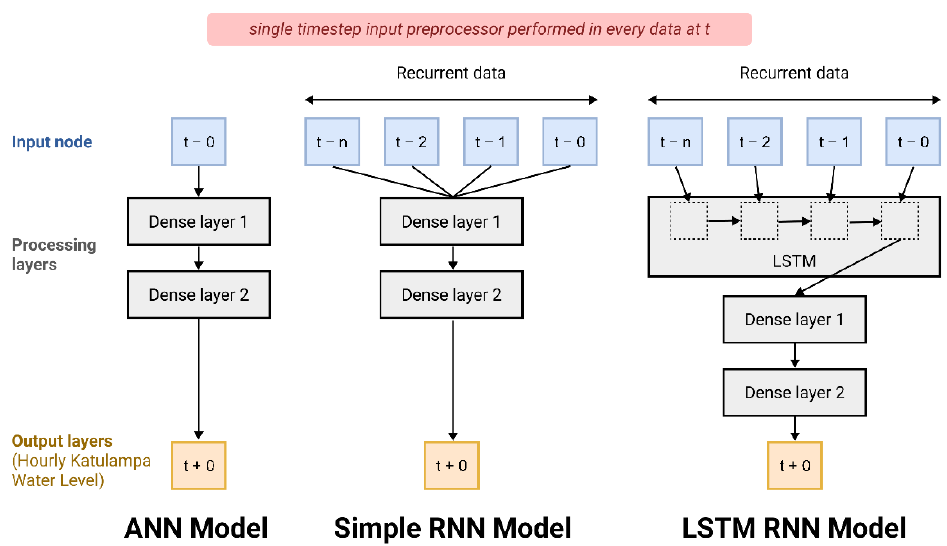
Figure 4. ANN, RNN, LSTM model schematics.